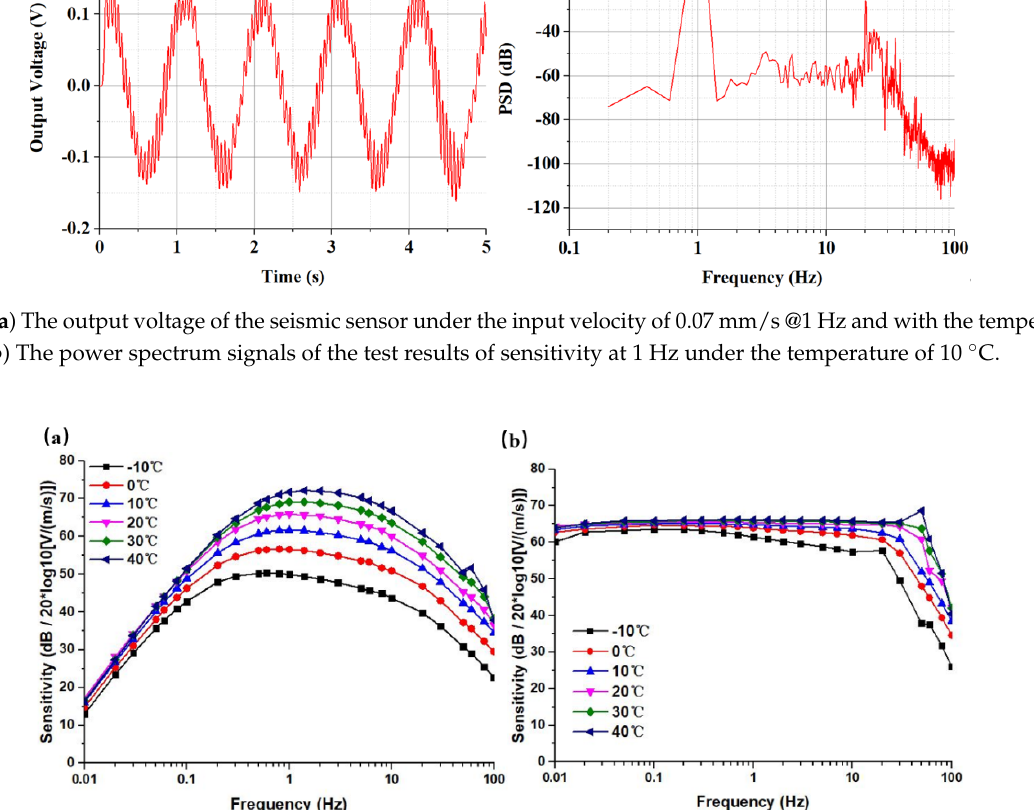
Figure 6. ( a ) The open-loop sensitivity curves at a temperature range of −10 °C ~ 40 °C. ( b ) The closed-loop sensitivity curves at a temperature range of −10 °C ~ 40 °C .